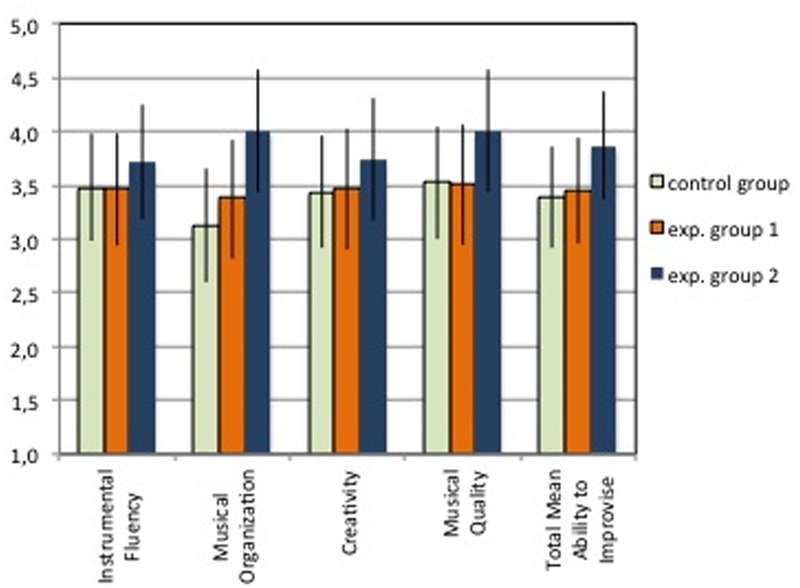
Solo task: Scores for each evaluative criteria and the Total score of Ability to Improvise (means). The error bars indicate 95% confidence intervals.